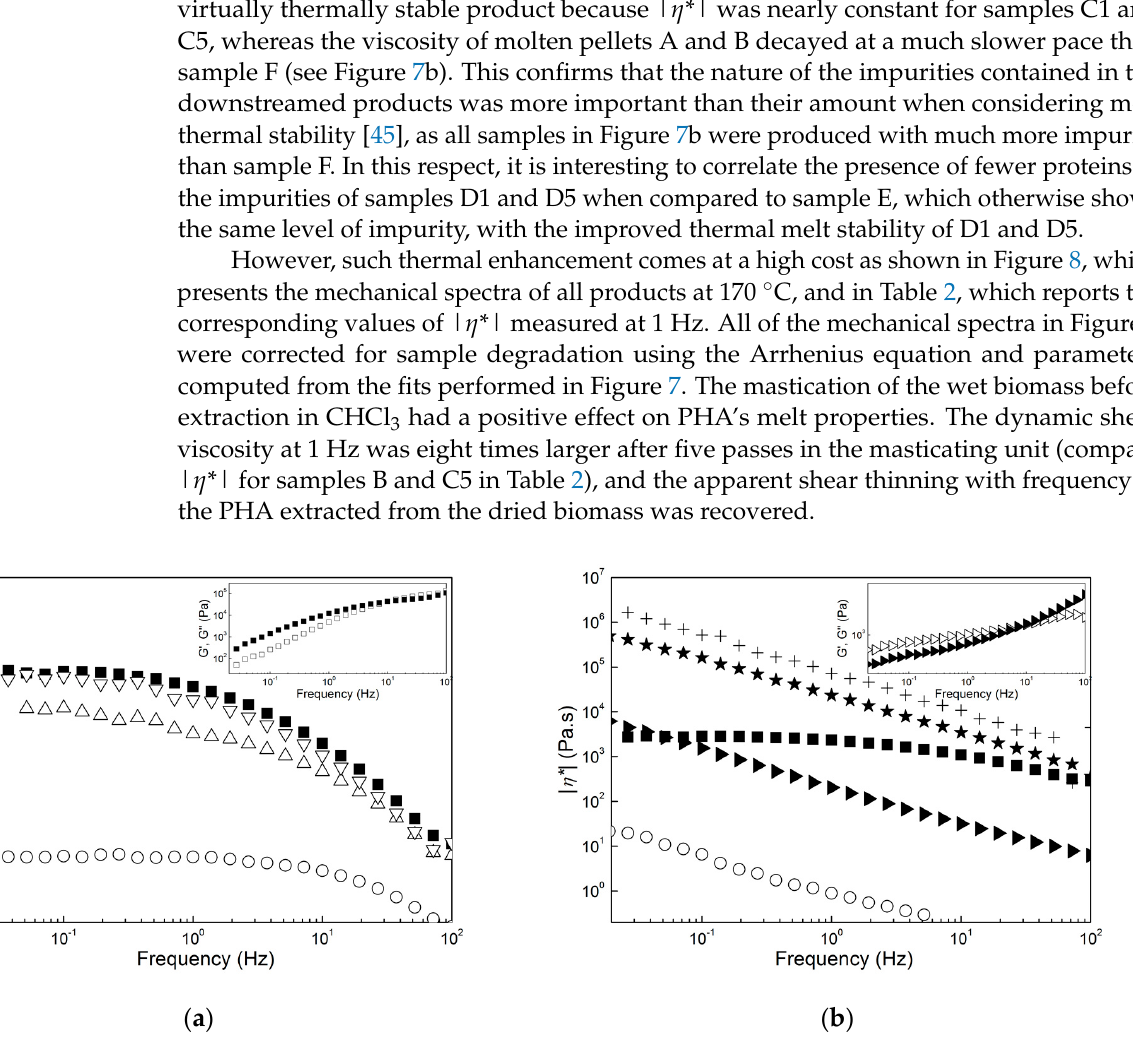
Figure 8. Mechanical spectra (dynamic shear viscosity | η *| as a function of frequency) measured at 170 °C. ( a ): Sample F (squares), sample E (circles), sample D1 (up triangles) and sample D5 (down triangles); ( b ): sample F (squares), sample C1 (circles), sample C5 (left triangles), sample B (stars) and sample A (crosses). Inset in ( a ): mechanical spectrum (storage modulus G’ (solid symbols) and loss modulus G’’(empty symbols) as a function of the frequency) of sample F. Inset in ( b ): mechanical spectrum of sample